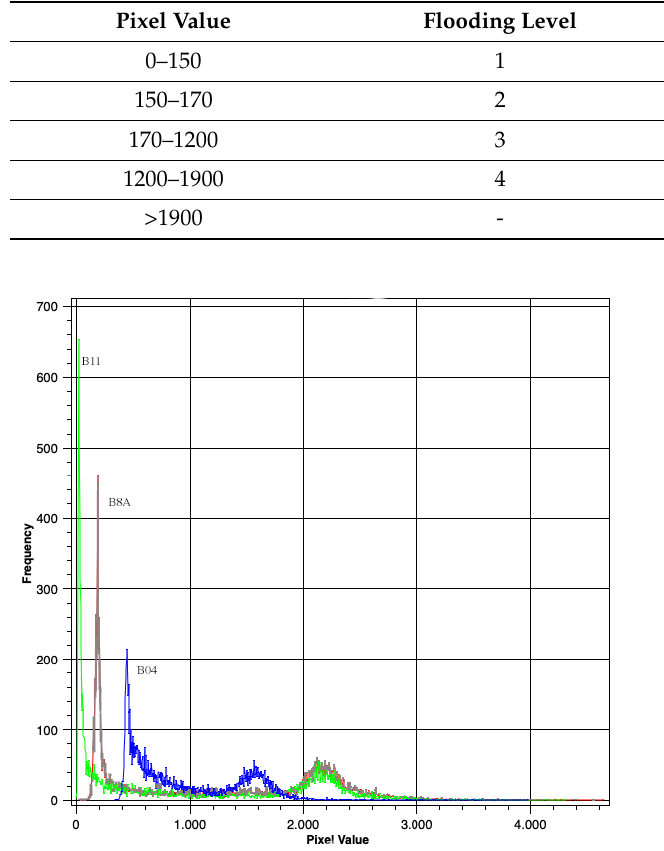
Table 2. Winter flooding levels of paddy fields constructed from B8A–B11–B04 layer combinations of Sentinel-2 images from 1 January 2019.